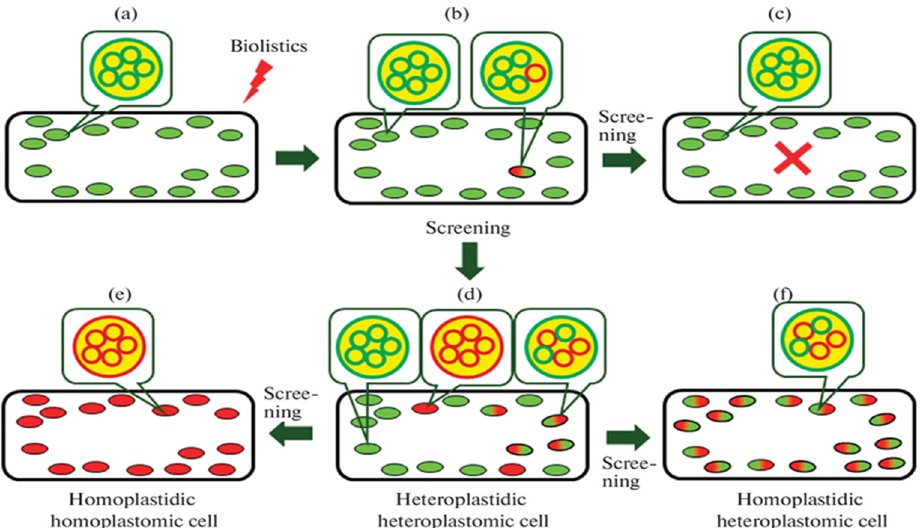
Figure 2. Reorganization of the plastid genome after selection on selective media to achieve homo- plastomy and homoplastidic status. ( a ) Introduction of a genetic construct into plastids. ( b ) Insertion of one or more copies of a transgene into the plastid genome via homologous recombination. ( c ) Cells without insertions extinct. ( d – f ) Outcomes of cell selection on a medium with a selective agent (usually, antibiotic spectinomycin alone or with streptomycin). Green ovals within the cell boundaries are native chloroplasts with the untransformed genome; two-color ovals: chloroplasts containing transgenic and nontransgenic copies of the genome (heteroplastomic chloroplasts); red ovals: chloro- plasts containing only transformed copies of the genome (homoplastomic chloroplasts); callouts show individual chloroplast nucleoids containing only nontransgenic copies of the genome (green circles), nucleoids containing a mixture of transgenic and nontransgenic copies of the genome (a combination of green and red circles), and nucleoids containing only transgenic copies of the genome (red